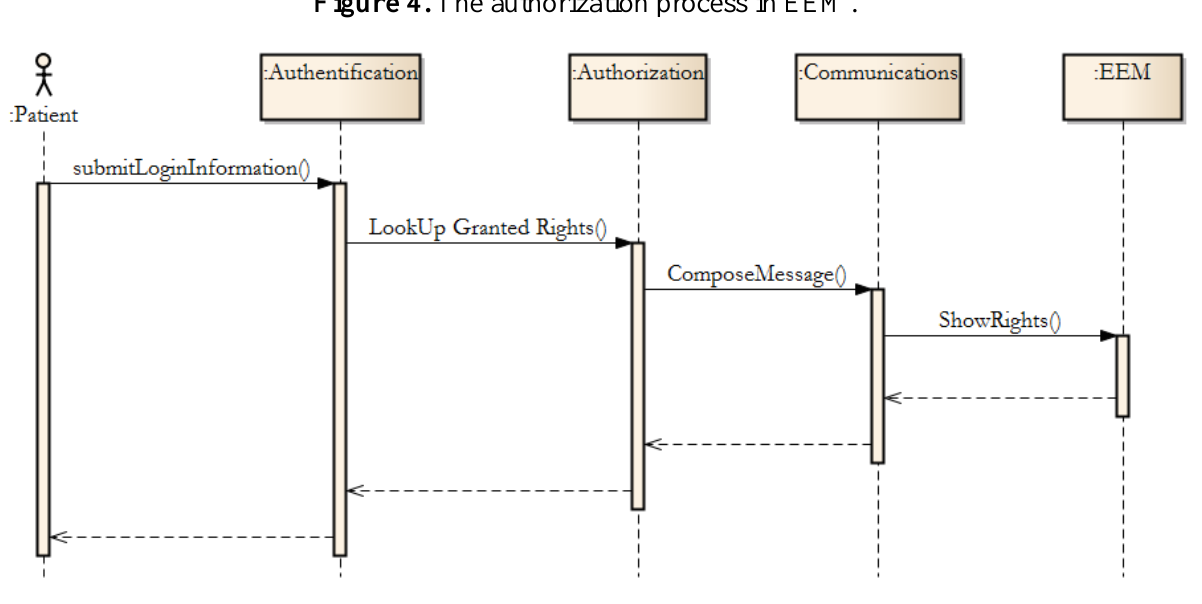
Figure 4. The authorization process in